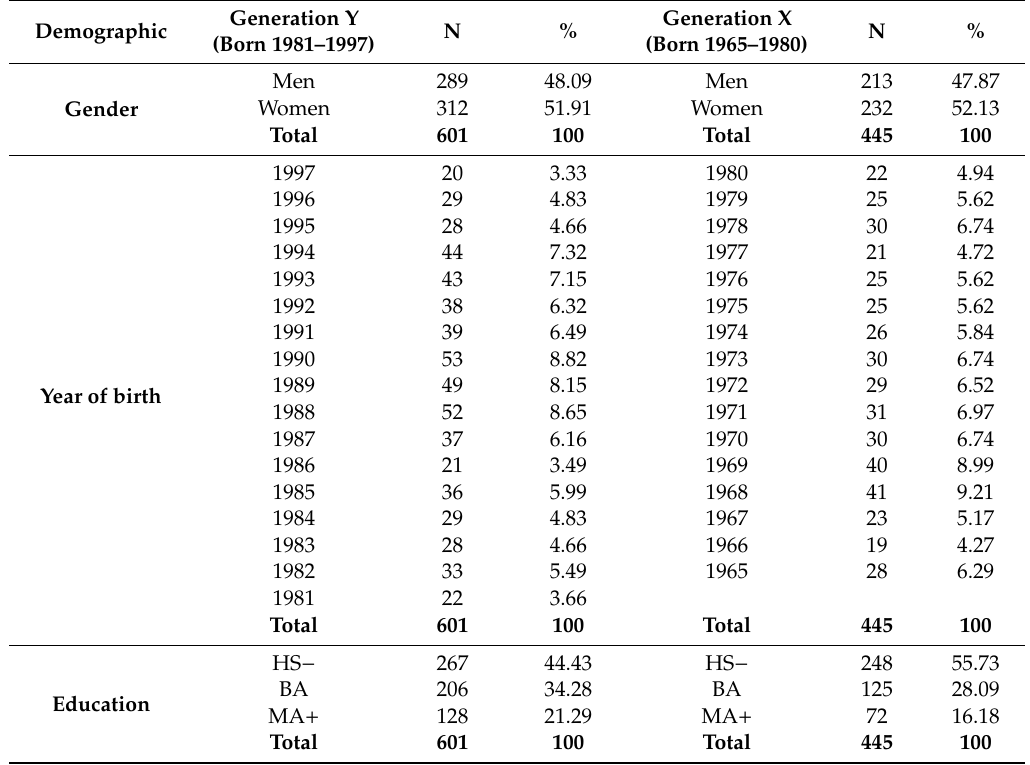
Table 1. Sample demographics.